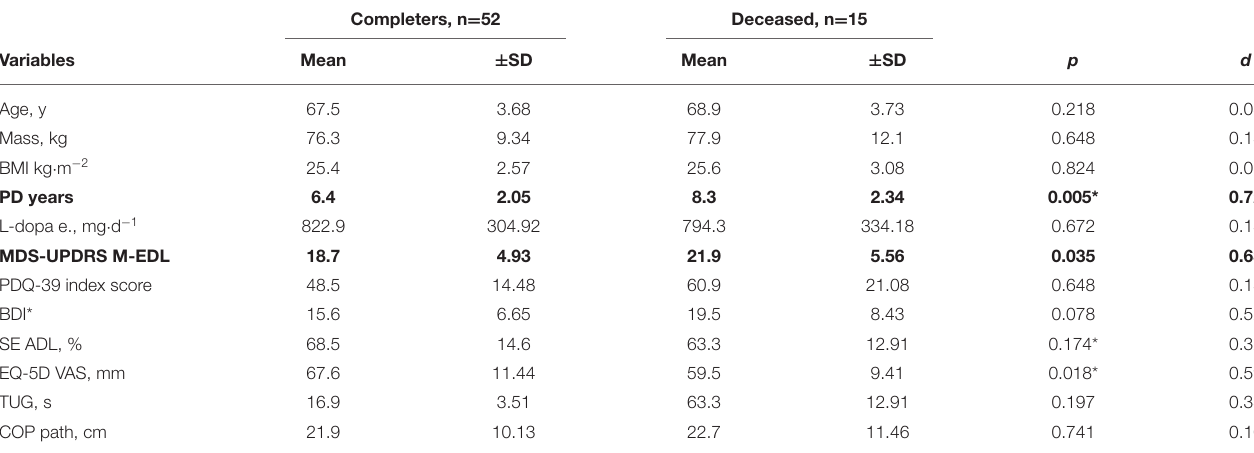
TABLE 2 | The comparisons of the patients who completed and those who deceased during the 6-year-long study. Completers, n =